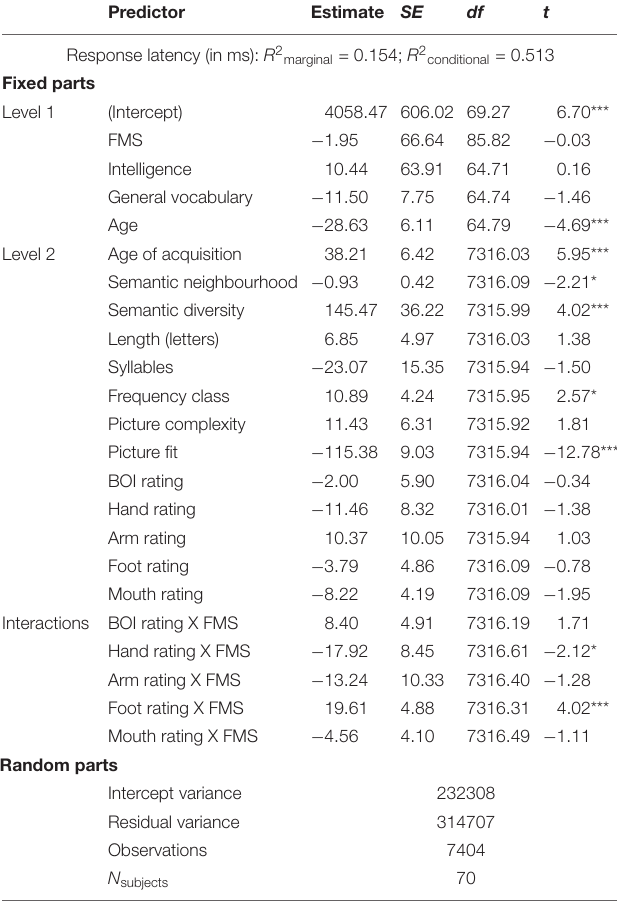
TABLE 3 | Mixed effects model predicting childrens’ response latencies from fine motor skills (FMS), cognitive factors, age in months, word variables, BOI ratings, and body-part association